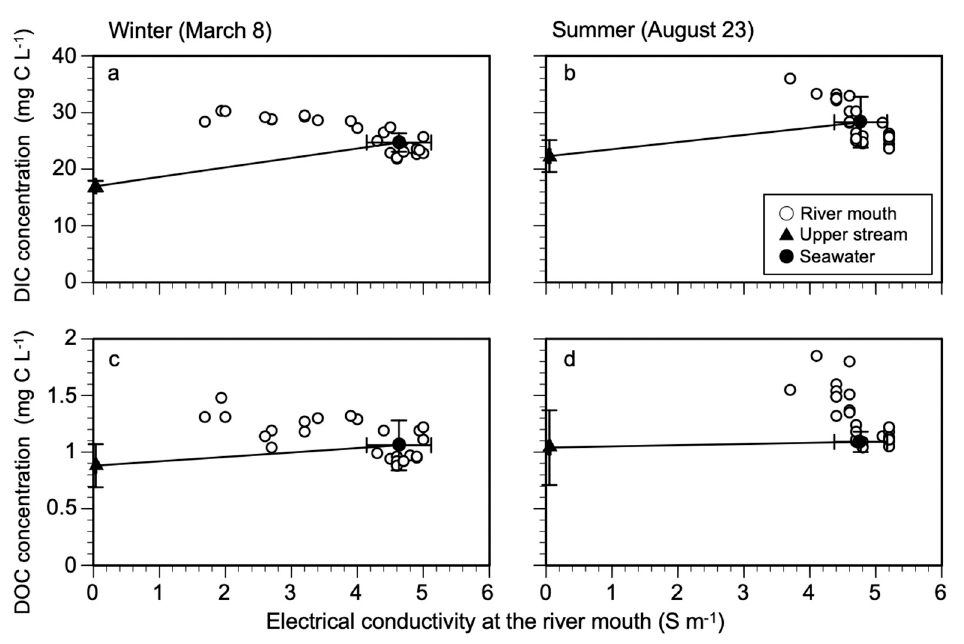
Figure 4. Relationship between EC and DIC (or DOC) concentrations at the river mouth water with tidal exchange (open circles) in a small estuarine mangrove in the winter ( a , c ) and summer ( b , d ). The line indicates the modeled carbon concentration (C mix ) derived by the conservative mixing of seawater (filled circle) and freshwater (filled triangle) with standard error (SE) as endmembers.